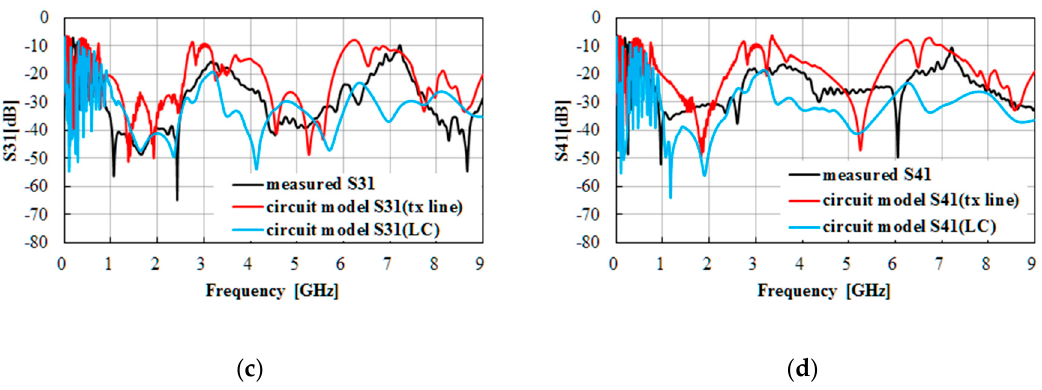
Figure 7. Scattering parameters of the simulation (circuit model) and measured result. ( a ) S 11 ; ( b ) S 21 ; ( c ) S 31 ; ( d ) S 41 .